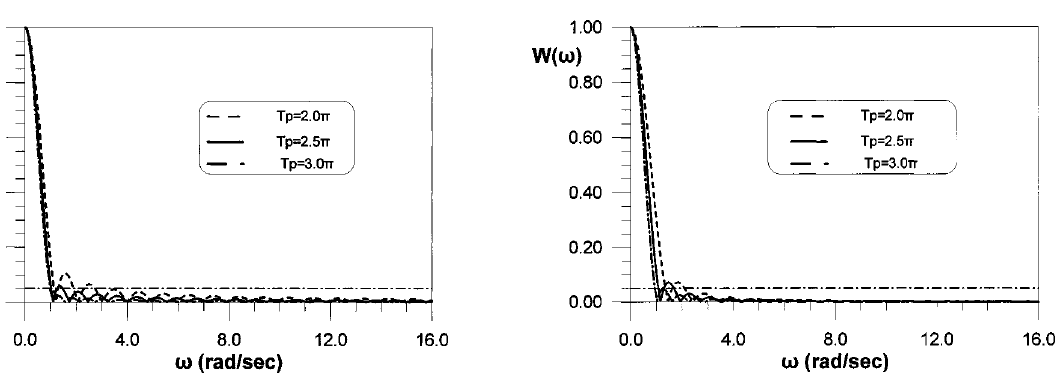
Fig. 6. Effect of the total pulse duration time T p on the error function of Chebyshev I method ( N =